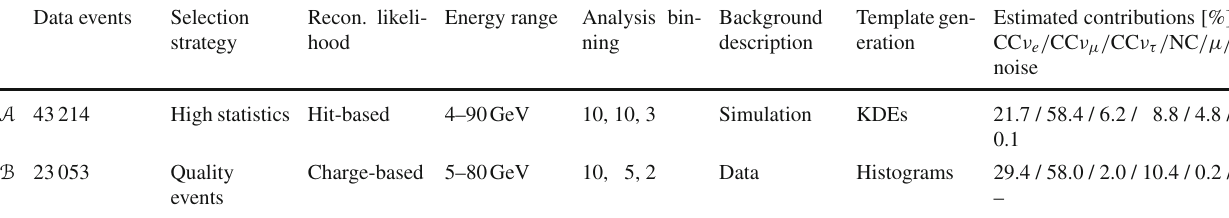
Table 1 Overview of the main differences between the two NMO anal- yses in terms of the total number of observed events, the selection strat- egy, the reconstruction likelihood, the reconstructed energy range,